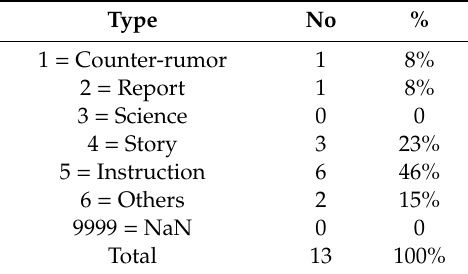
Table A3. The article